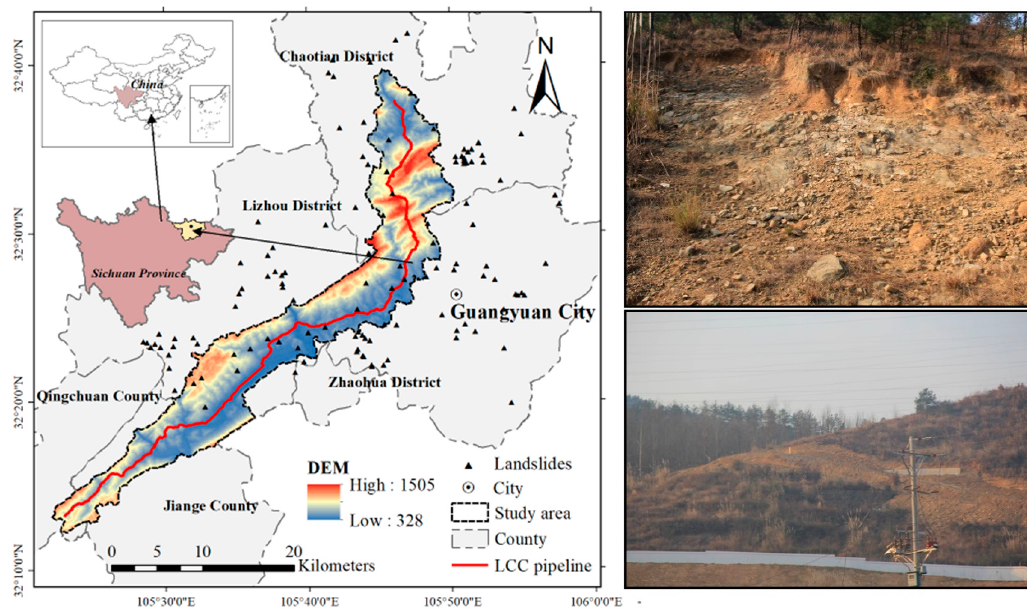
Figure 1. Location and field environment of the study area in Guangyuan city, Sichuan, China.